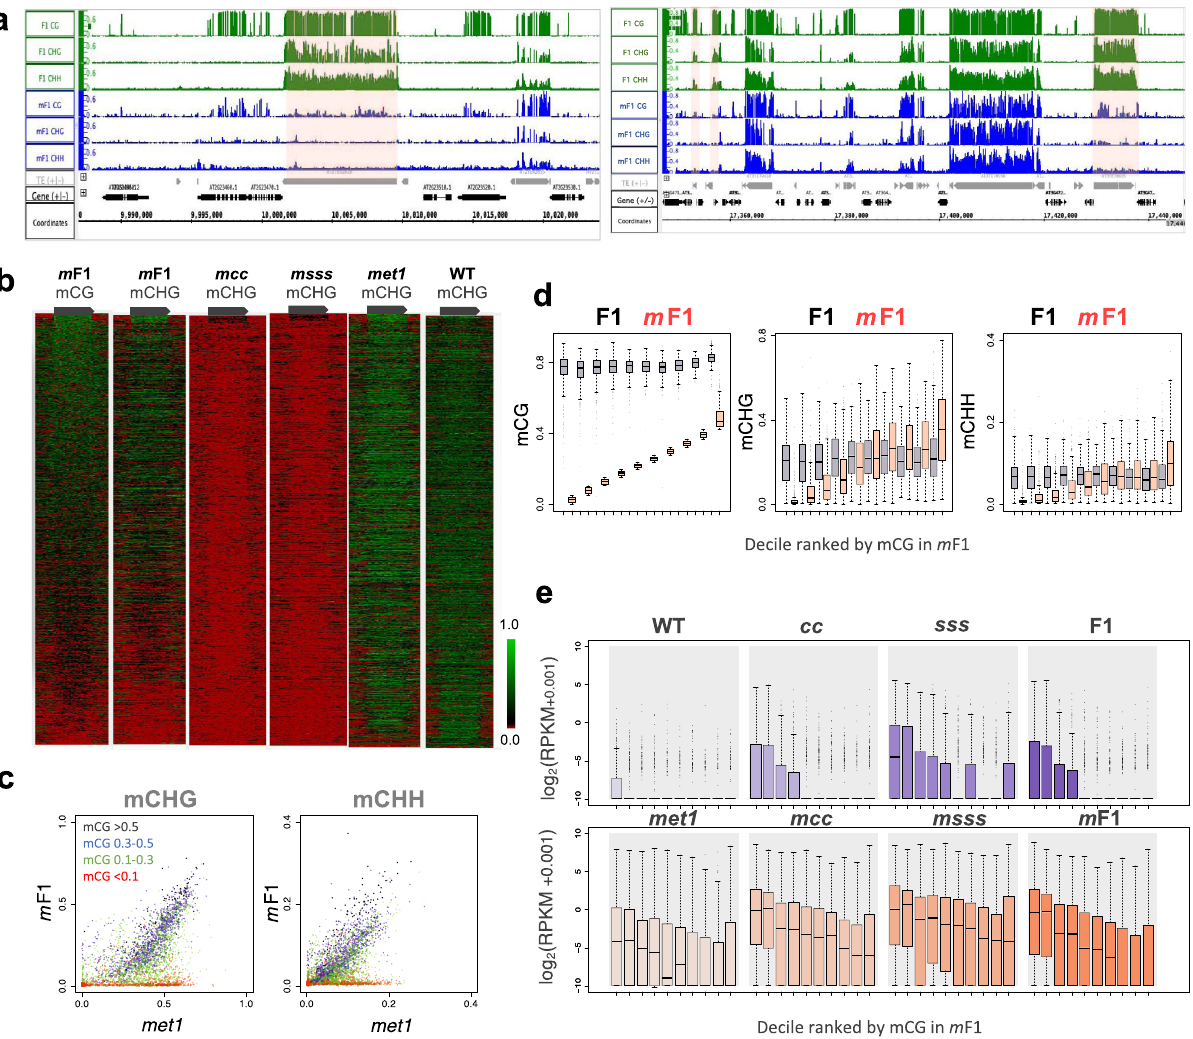
Fig. 2 Loss of mCG is associated with loss of mCH recovery. a Genome Browser view of mCG, mCHG, and mCHH in F1 and m F1 plants. TEs with loss of mCG fail to restore mCH in m F1 (highlighted in pink). The regions of Chr2/9,987,000 – 10,024,000 (left) and Chr1/16,420,326 – 16,439,454 (right) are shown. Gray and black arrows represent TEs and genes, respectively. b mCHG recovers in TE genes with remaining mCG. Each TE gene (length > 1000; n = 2422) is aligned according to the mCG levels in m F1 (left) and the methylation levels of TE genes and their fl anking regions (2 kb) are shown in the form of a heatmap for each genotype (see Methods). Gray arrow represents TE gene from TSS to TTS. c Recovery of mCHG (left) and mCHH (right) is associated with the residual mCG in m F1. The scatter plots shown in the right panel of Fig. 1e and Fig. 1k were colored according to the residual mCG in m F1. Red: <0.1, green: 0.1 – 0.3, blue: 0.3 – 0.5, and black: >0.5 for mCG in m F1. d Boxplots showing the association of mCH recovery in m F1 with their